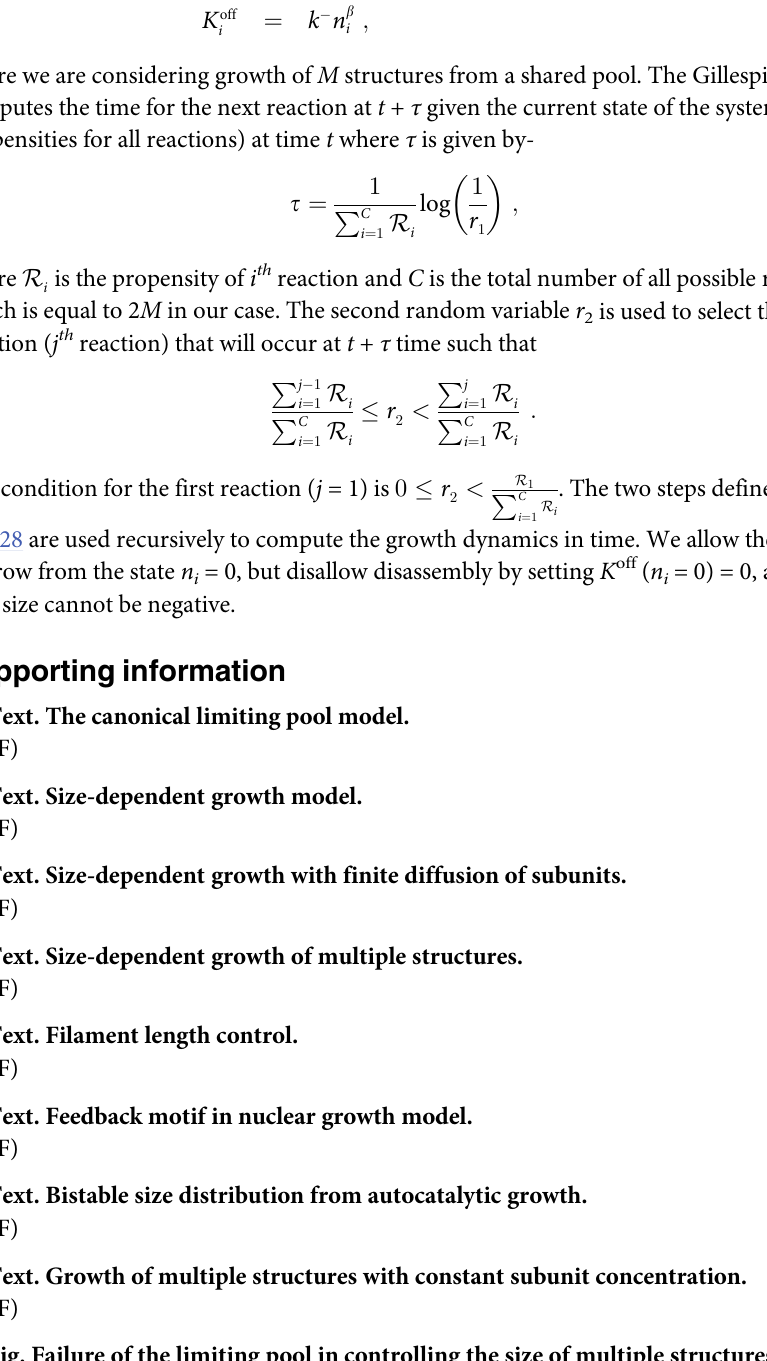
S1 Fig. Failure of the limiting pool in controlling the size of multiple structures. (A) For a single structure, the limiting pool model can provide robust size control. The structure reaches a steady state size after an initial period of fast growth. (B) The steady state size distribution shows a unimodal peaked distribution, characterising a well-defined mean size for